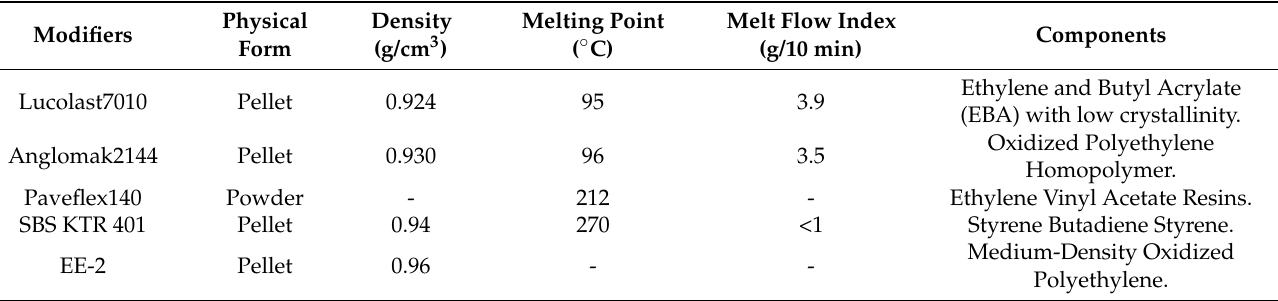
Table 5. The rheological and physical properties of PMA.